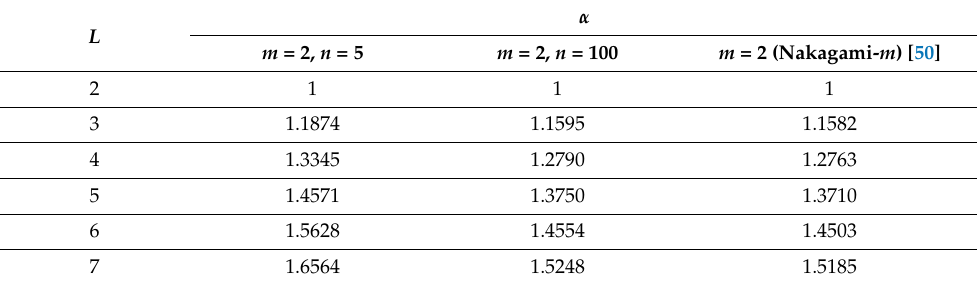
Table 3. Value of α under different numbers of branches of SEC when γ ∗ τ = αγ over various fading